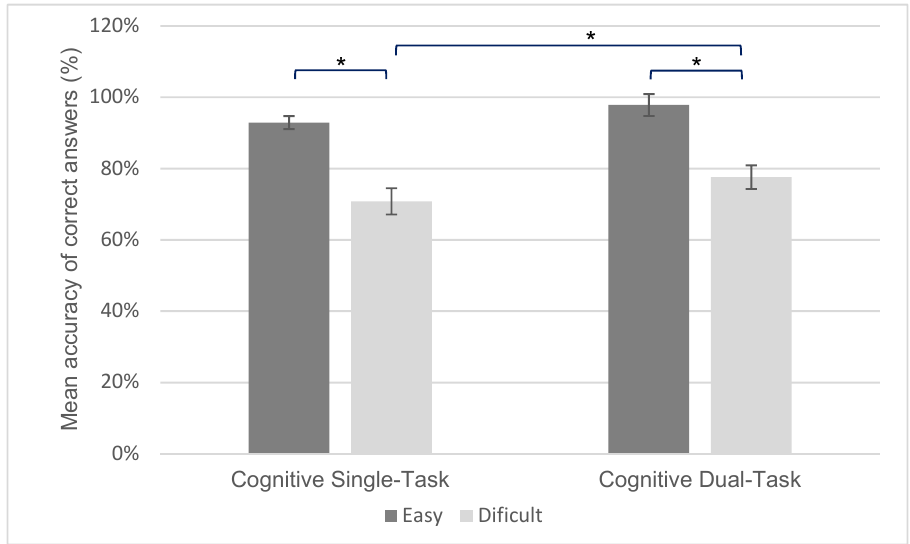
Figure 2. Mean accuracy and standard errors (error bars) of the percentage of the correct answers during cognitive single-task and dual-task. * p < 0.05-significant difference between difficult cognitive single-task and difficult dual-task, easy and difficult cognitive single-task, easy and difficult dual-task; not statistically significant between easy cognitive single-task and easy dual-task (Wilcoxon signed-rank test).